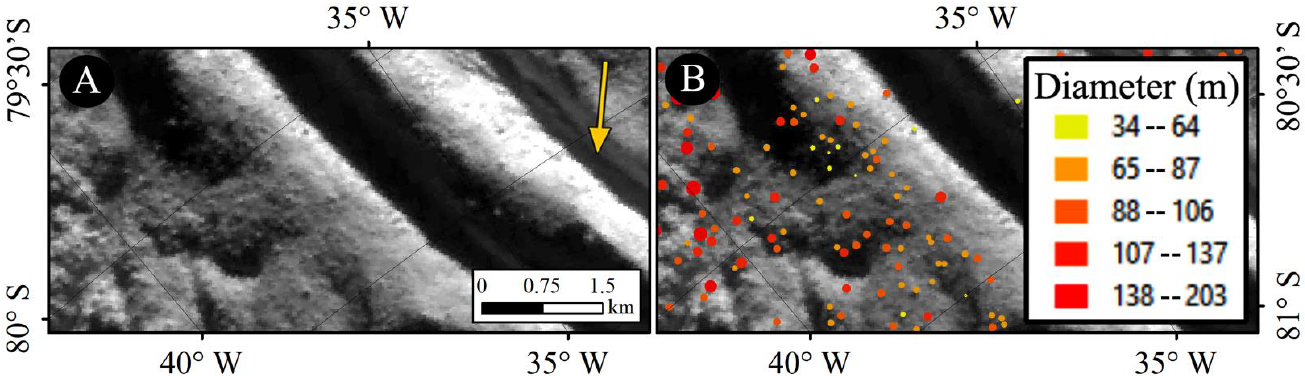
Figure 3. Methodology used to identify the blocks located on Enceladus tiger stripes. ( A ) Subframe of the ISS-NAC N1597182500 image. The yellow arrow shows the direction of the solar irradiation. ( B ) The identified blocks are grouped in size (m).